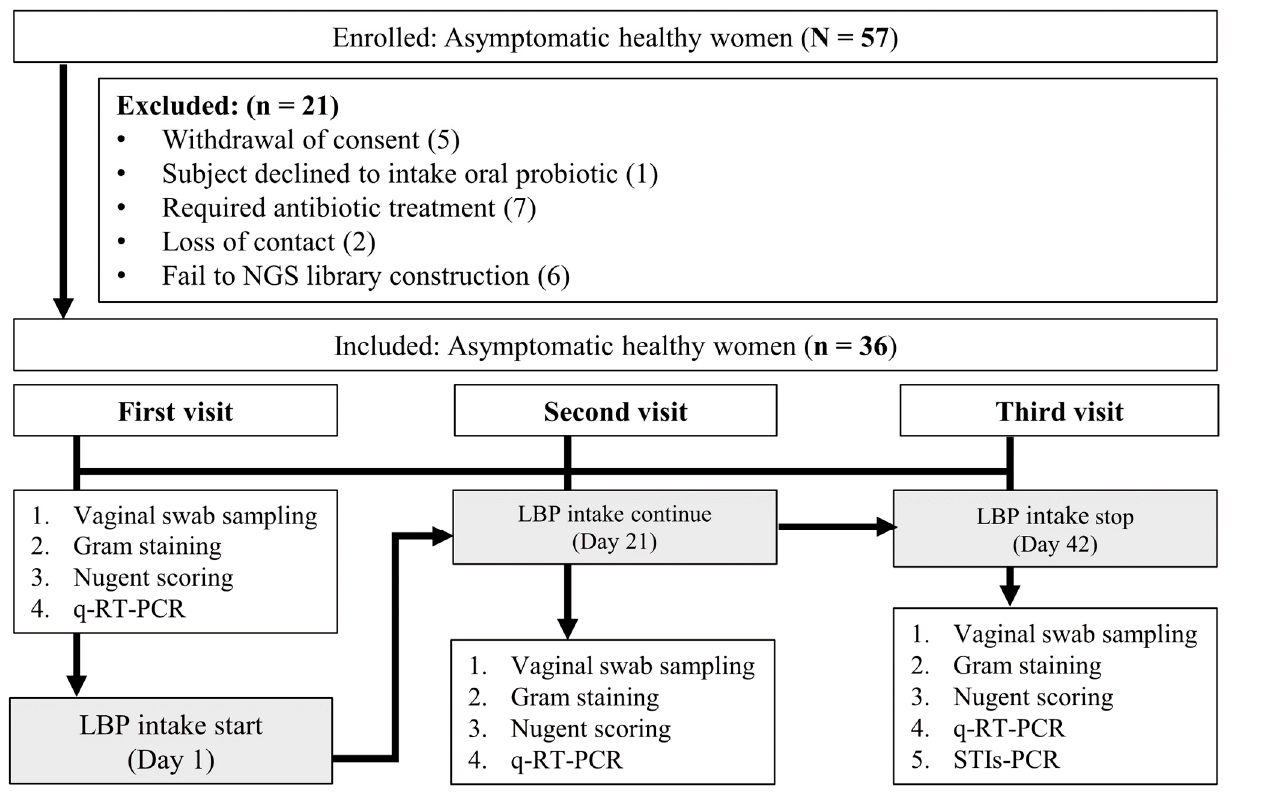
Figure 1. Flow chart of subject analysis. qRT-PCR, quantitative real-time polymerase chain reaction; LBP, Lactobacillus probiotic; STI-PCR, sexually transmi tt ed infection polymerase chain reaction.